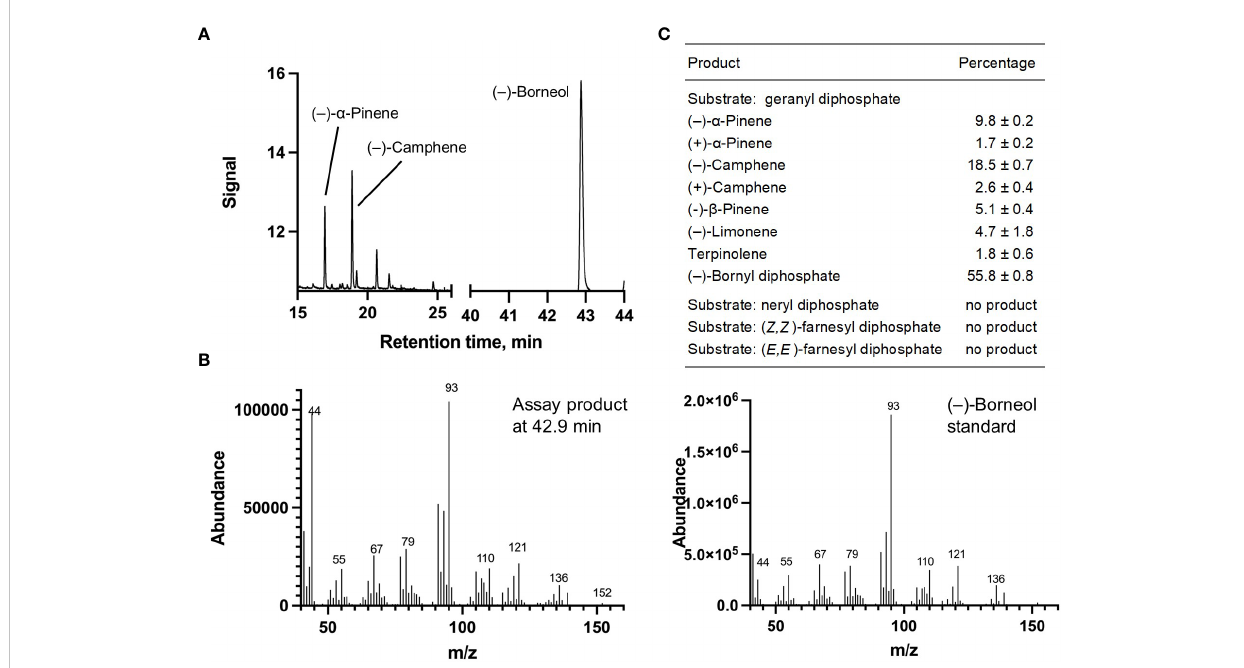
FIGURE 7 Characterization of M. longifolia CMEN 585 candidate Ml_38055. (A) GC chromatogram with annotation for major peaks; (B) mass spectrum of the main enzymatically generated product (following hydrolysis) and the matching authentic standard [( – )-borneol, which is hydrolytically released from bornyl diphosphate]; and (C) tabulated product pro fi